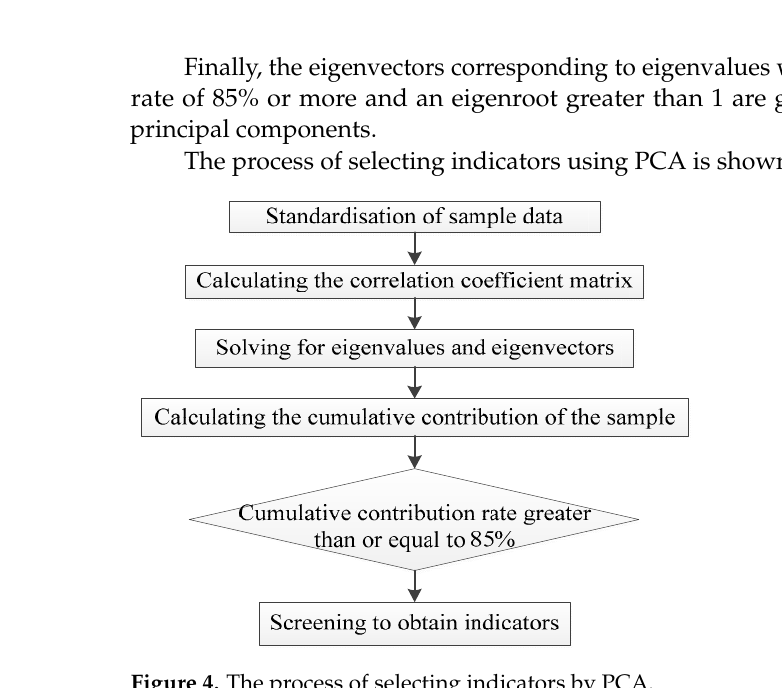
Figure 4. The process of selecting indicators by PCA.